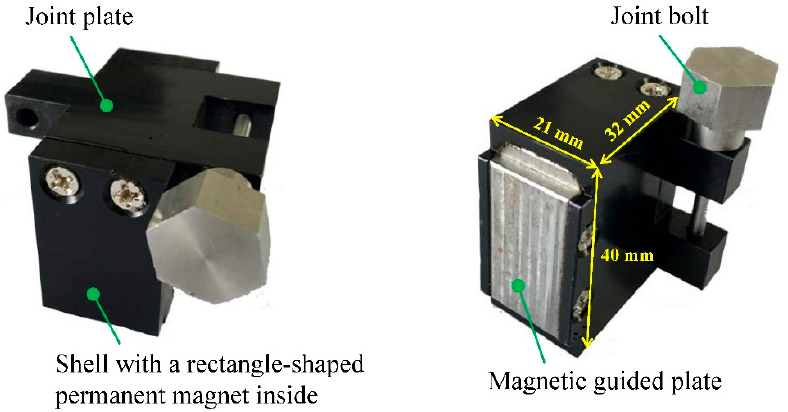
Figure 9. The photograph of the magnetization unit with different views.